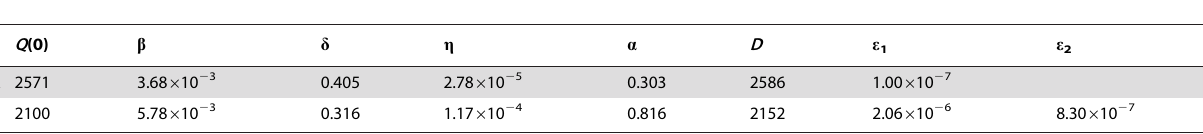
Table 1. Parameter estimates based on the weight data.